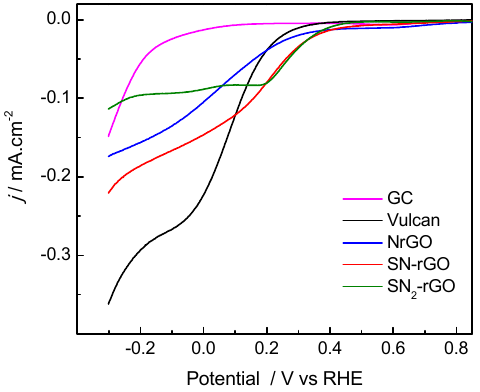
Figure 5. Steady ‐ state polarization curves for O 2 reduction at 1600 rpm in 0.5 M H 2 SO 4 at 25 °C for all studied electrocatalysts, with sweep rate of 0.002 V s − 1 .